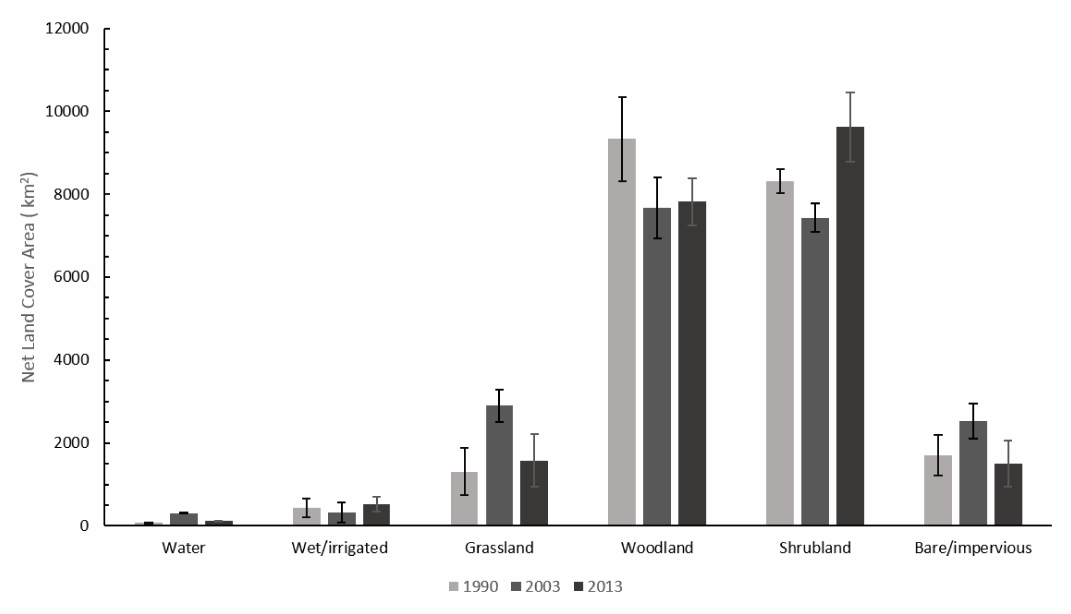
Figure 5. Estimated net area (km 2 ) for Chobe District land cover in 1990, 2003, and 2013. Bars show estimated error calculated using field and training site data. Estimated errors for consecutive time steps were less than net change for all classes except wet/irrigated in all three years, and woodland in 2003 and